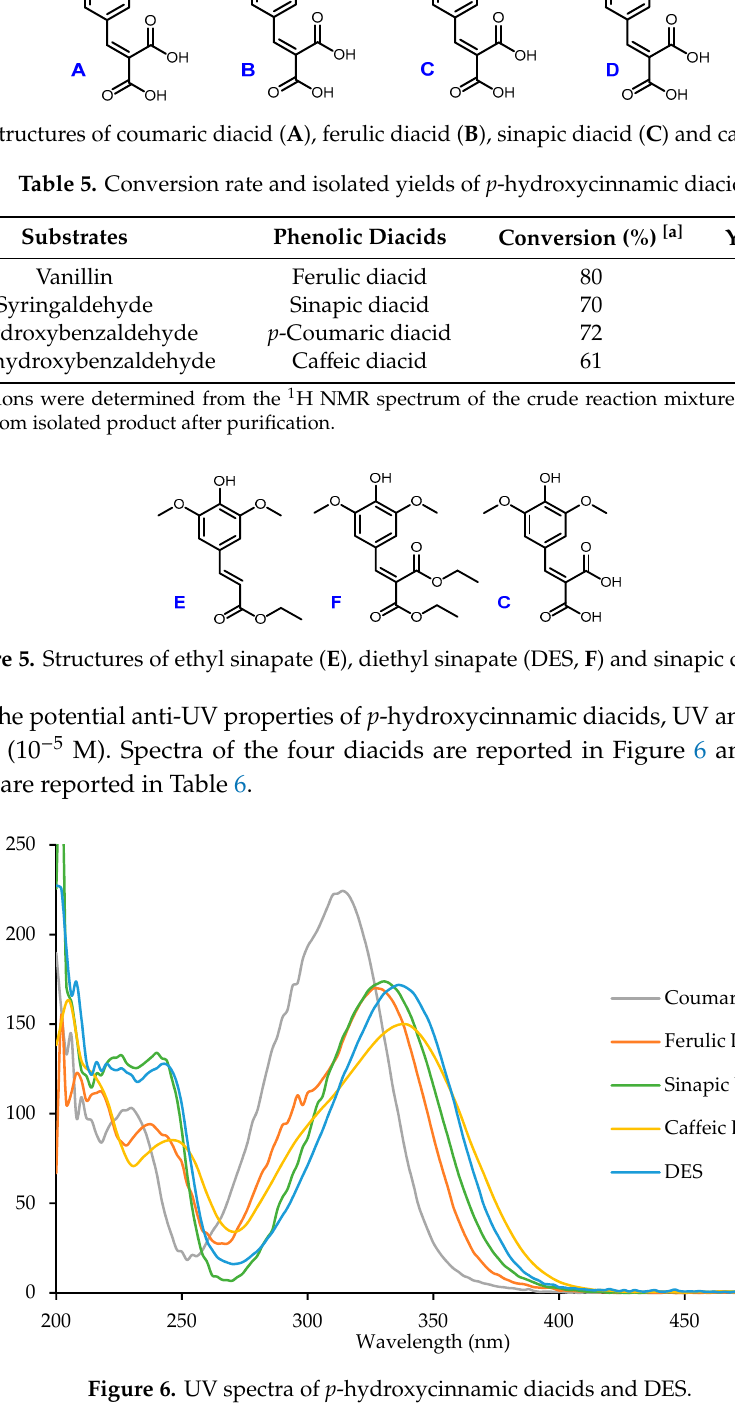
Figure 6. UV spectra of p -hydroxycinnamic diacids and DES.